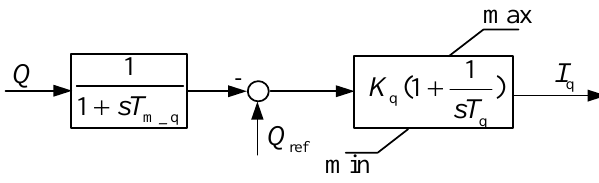
Figure 7. Block diagram of reactive power control module.